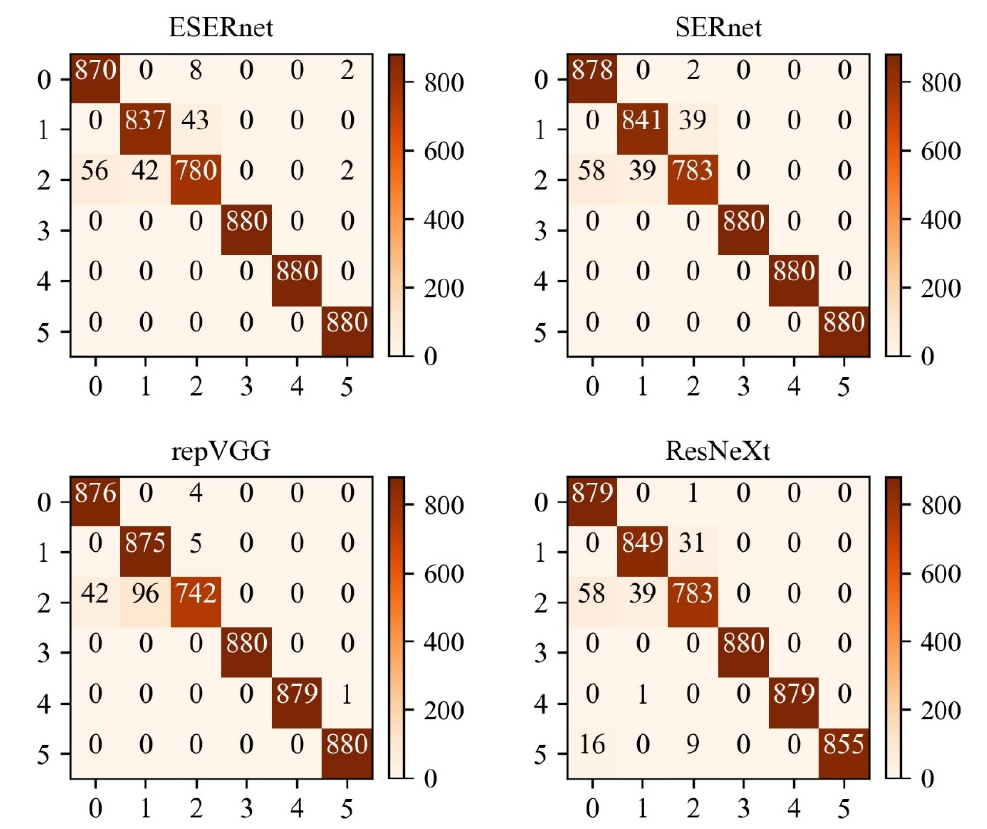
Figure 9. Confusion matrix for 4 model test sets. Row numbers 0 to 5 represent normal, large chunks falling, material block, coal breaking, slag hanging, and wind off. The column number 0~5 category is the same as the row number.